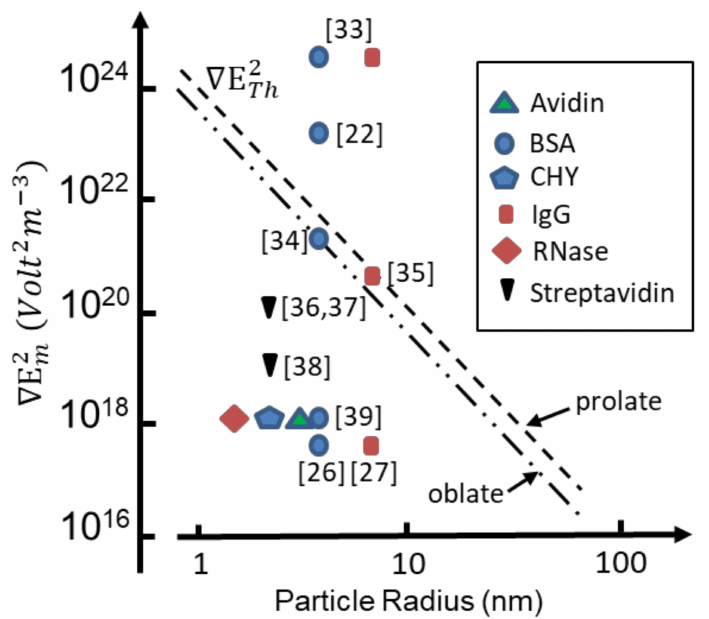
Figure 2. Reported values of ∇ E 2 m employed in DEP experiments mapped against the effective (hy- drodynamic) radius of the test protein molecule. The straight-line plots show the predicted threshold values of ∇ E 2 required to overcome Brownian forces, derived using Equation (13) for prolate and Th oblate spheroids. (BSA: bovine serum albumin; CHY: chymotrypsinogen; IgG: immunoglobulin